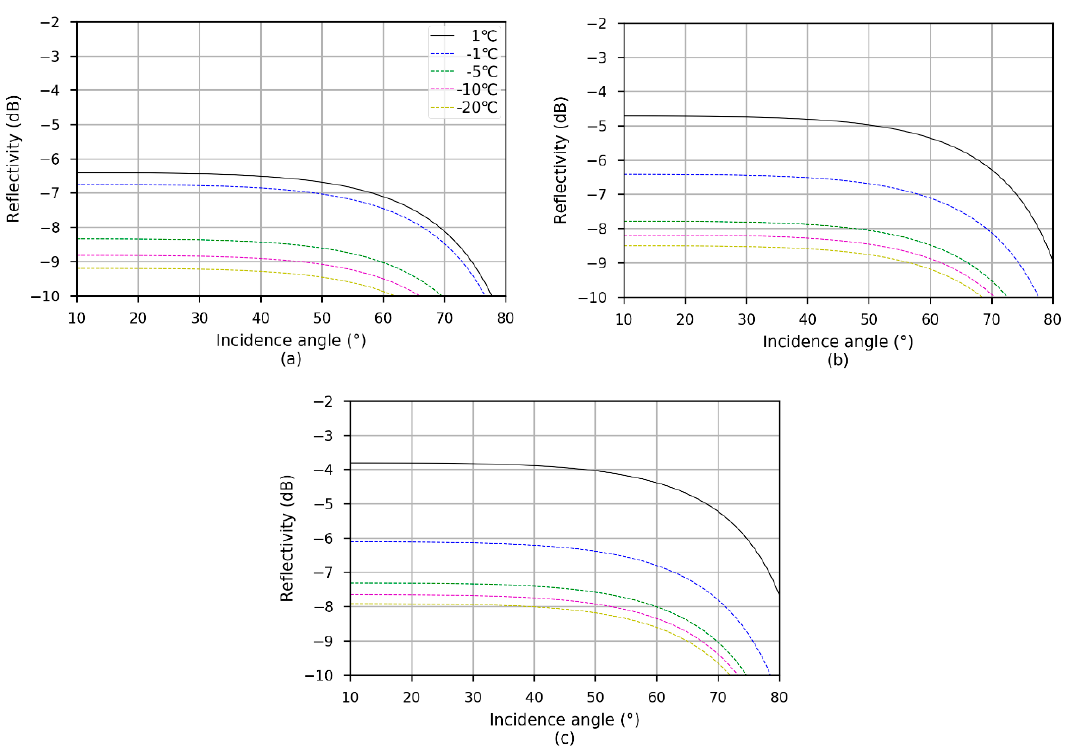
Figure 2. The relationship of soil reflectivity and incident angle under different temperature with soil moisture 0.1 cm 3 /cm 3 (a) , 0.2 cm 3 /cm 3 (b) , and 0.3 cm 3 /cm 3 (c) .